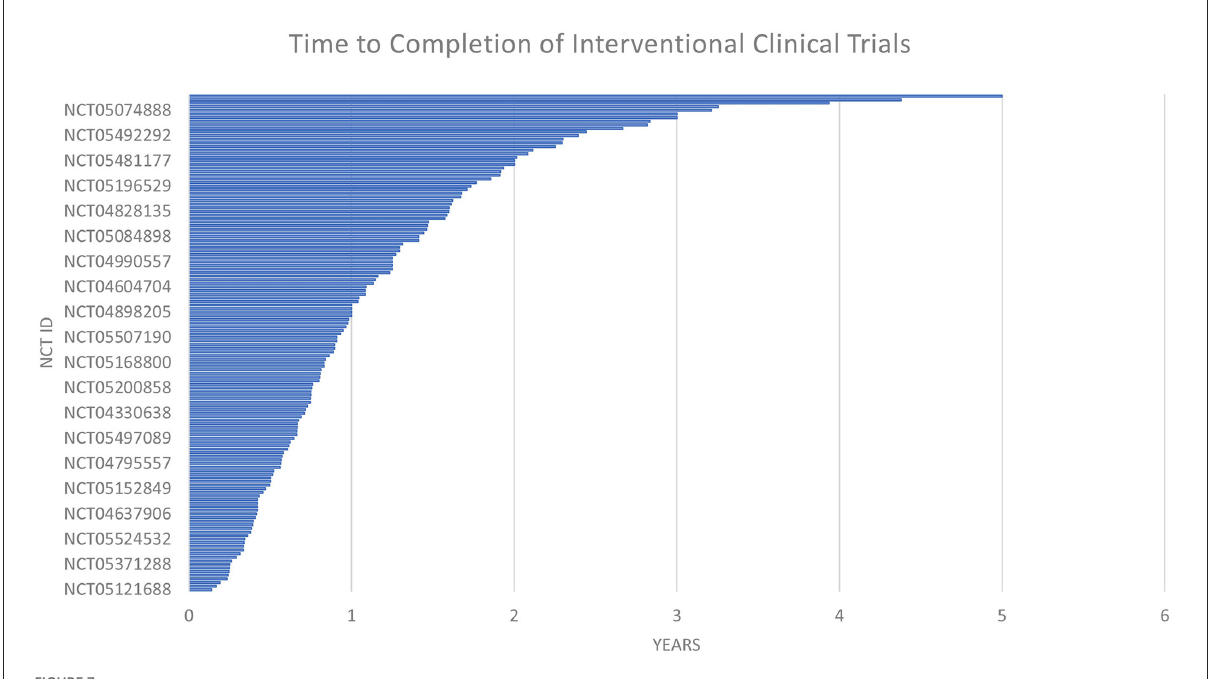
FIGURE7 The time to completion of interventional clinical trails.